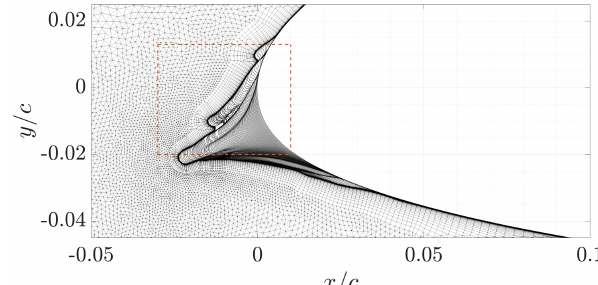
Figure 15. Multi-step ice accretion on Section B. The grid for the computation of the aerodynamic coefficients is superimposed onto the computed ice shape, highlighting the removal of highly concave regions. The region within the red box is enlarged in Fig. 16.